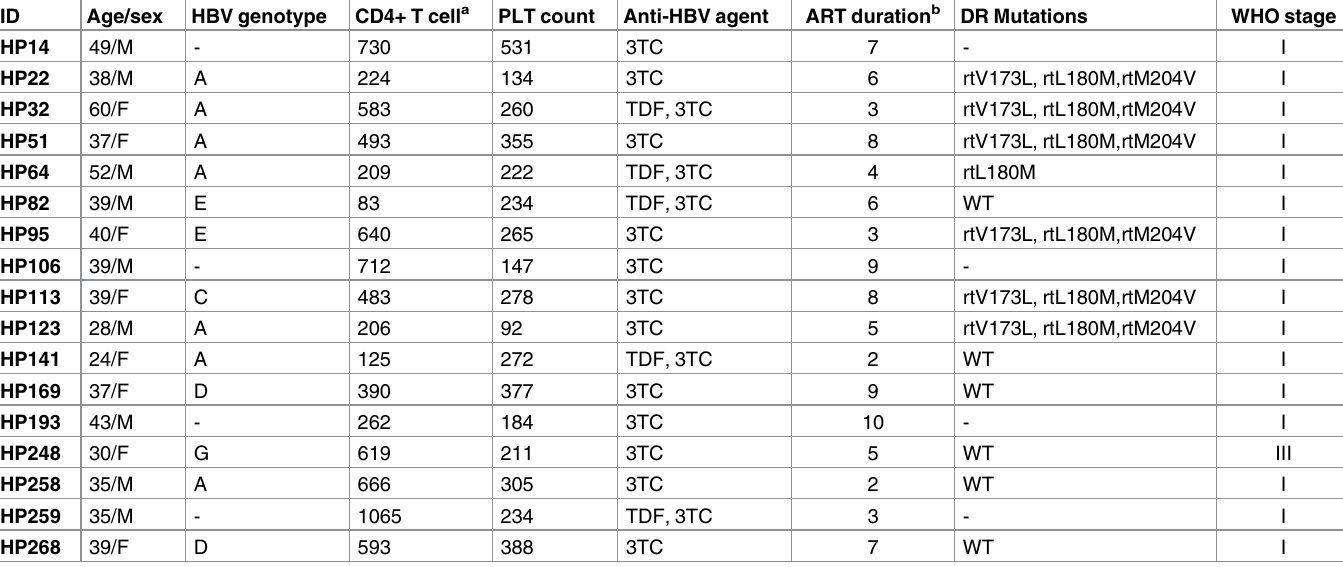
Table 2. Clinical and virological characteristics of HBV/HIV co-infected patients (n =